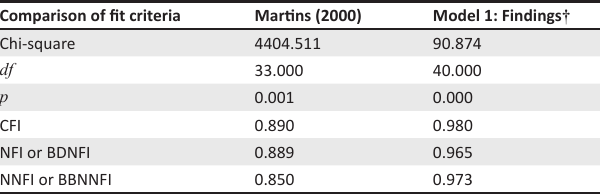
TABLE 3: Comparison of trust results.